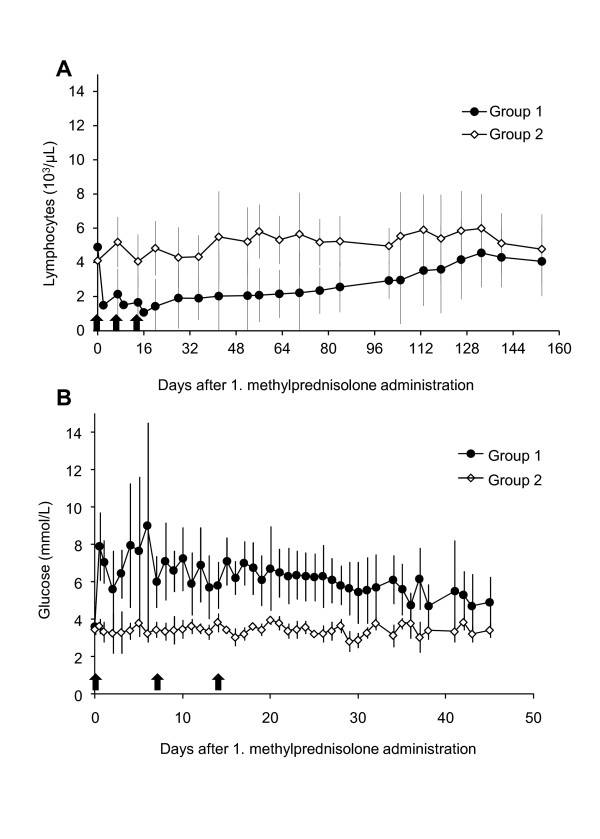
Lymphocyte counts (A) and blood glucose levels (B) of cats in groups 1 and 2. Values are depicted as mean +/- standard deviation. Black arrows = methylprednisolone administration. Cats in group 1 received the methylprednisolone administrations; cats in group 2 served as untreated control animals. A) Cats in group 1 had significantly lower lymphocyte counts than cats in group 2 (pMWU < 0.05) starting after the first methylprednisolone administration until day 70. B) Cats in group 1 had significantly higher blood glucose levels than cats in group 2 (pMWU < 0.05) starting after the first methylprednisolone administration at all collection time points with the exceptions of days 2, 11, and 36.